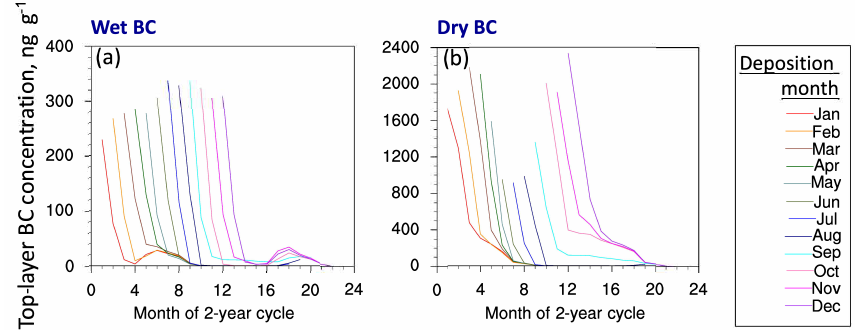
Figure 4. Temporal evolution of hydrophilic BC concentration (a) and hydrophobic BC concentration (b) in the top snow layer averaged over the Greenland region from the simulations with the maximum wet and dry BC deposition, respectively. Each line starts from the BC deposition month, extends 1 year, and represents the mean time series from 10 simulations that start in each year from 2006 to 2015.